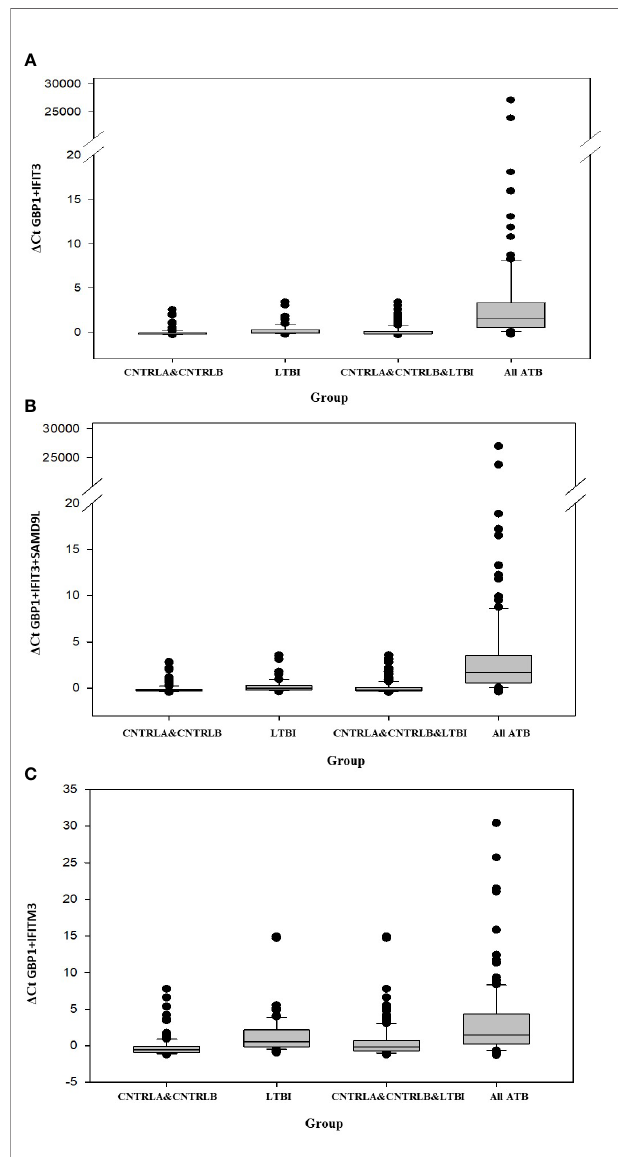
FIGURE 5 | Bar chart representation of the comparison between the combined CNTRLA and CNTRLB control groups, the LTBI group, the combined CNTRLA, CNTRLB and LTBI groups and the combined ATB groups (A) using the GBP1+IFIT3 algorithm (from Table 2 ), (B) using the GBP1+IFIT3+SAMD9L algorithm (from Table 2 ) (C) using the GBP1+IFITM3 algorithm (from Table 3